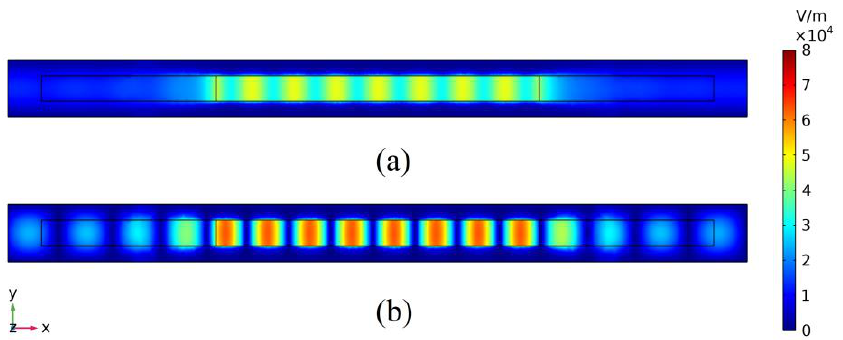
Figure 10. The electric field distribution of the traveling-wave state and the standing-wave state in the x–y plane. ( a ) Traveling-wave state; ( b ) Standing-wave state.